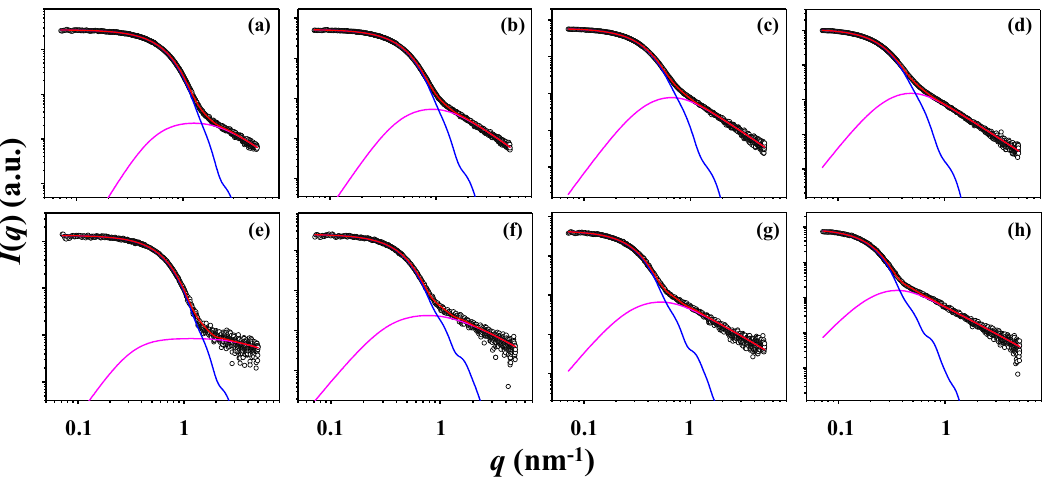
Figure 7. Quantitative fuzzy ellipsoidal model analysis results of X-ray scattering data in Figure 2 CHX at 35.0 ° C ( Θ condition): ( a ) 17-Arm(2k)-PS; ( b ) 17-Arm(6k)-PS; ( c ) 17-Arm(10k)-PS; ( d ) 17-Arm(20k)-PS; THF at 25.0 ° C (good solvent): ( e ) 17-Arm(2k)-PS; (f) 17-Arm(6k)-PS; ( g ) 17-Arm(10k)-PS; ( h ) 17-Arm(20k)-PS. The open symbols are the measured data and the red solid line represents the sum of the profiles obtained by fitting the data using fuzzy ellipsoid model (blue line) and blob contributions (purple line).